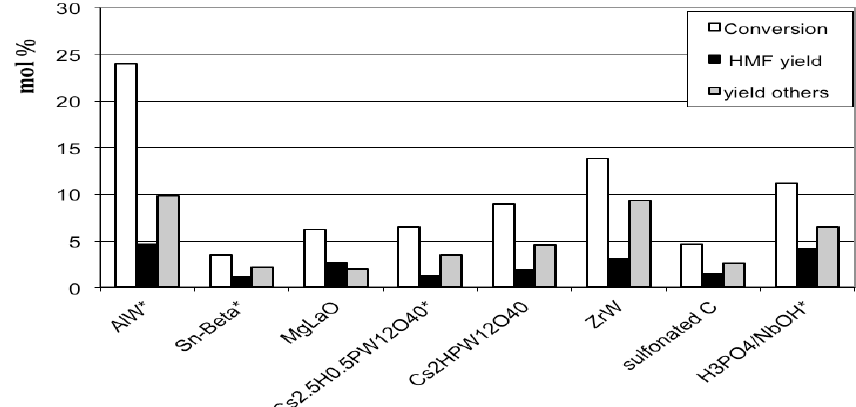
Figure 16. Glucose conversion in 20 wt% acetic acid aqueous solutions in the presence of added solid